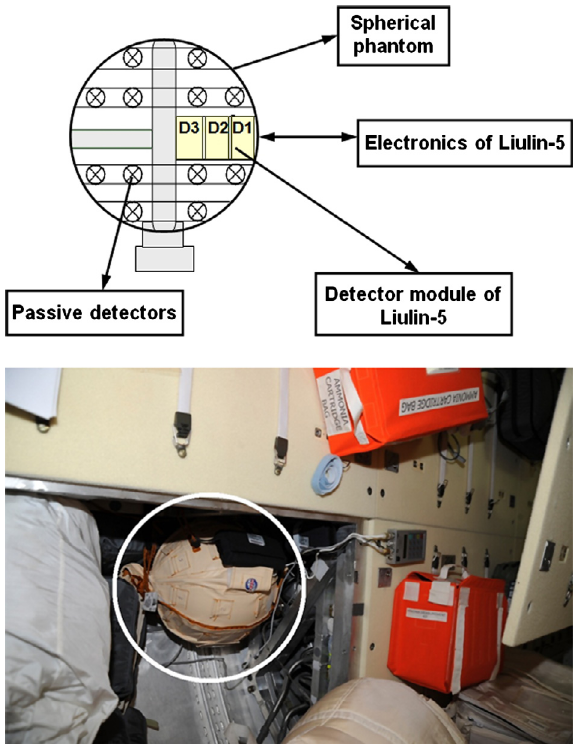
Fig. 2. Liulin-5 in the phantom. Upper panel – sketch of the detectors’ arrangement in the phantom. Bottom panel – the spherical phantom (marked in the white circle), located in the MIM1 module behind the panel 206. Inside the phantom (behind the label) is the detector module of Liulin-5.